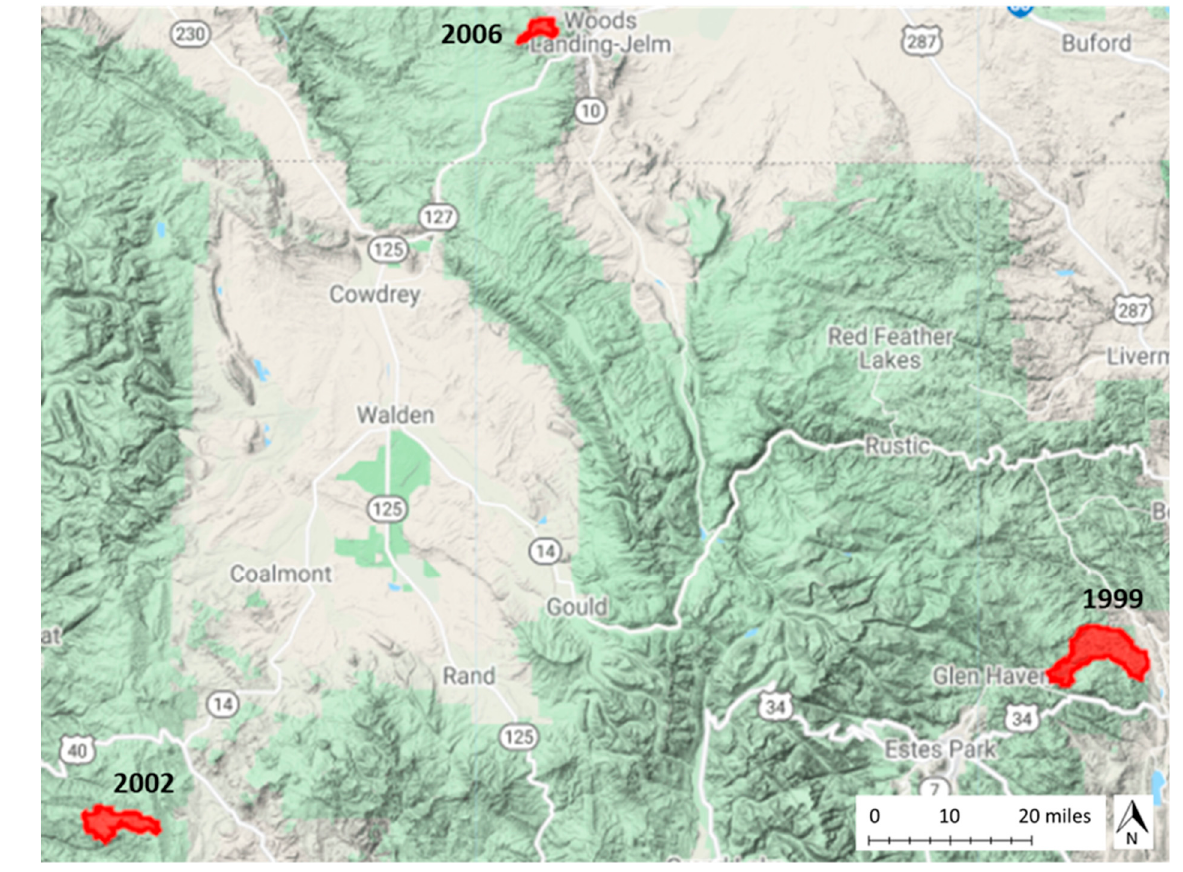
Figure 1. Map of the study area. Table 2. Site and stand characteristics of burned forest stands .